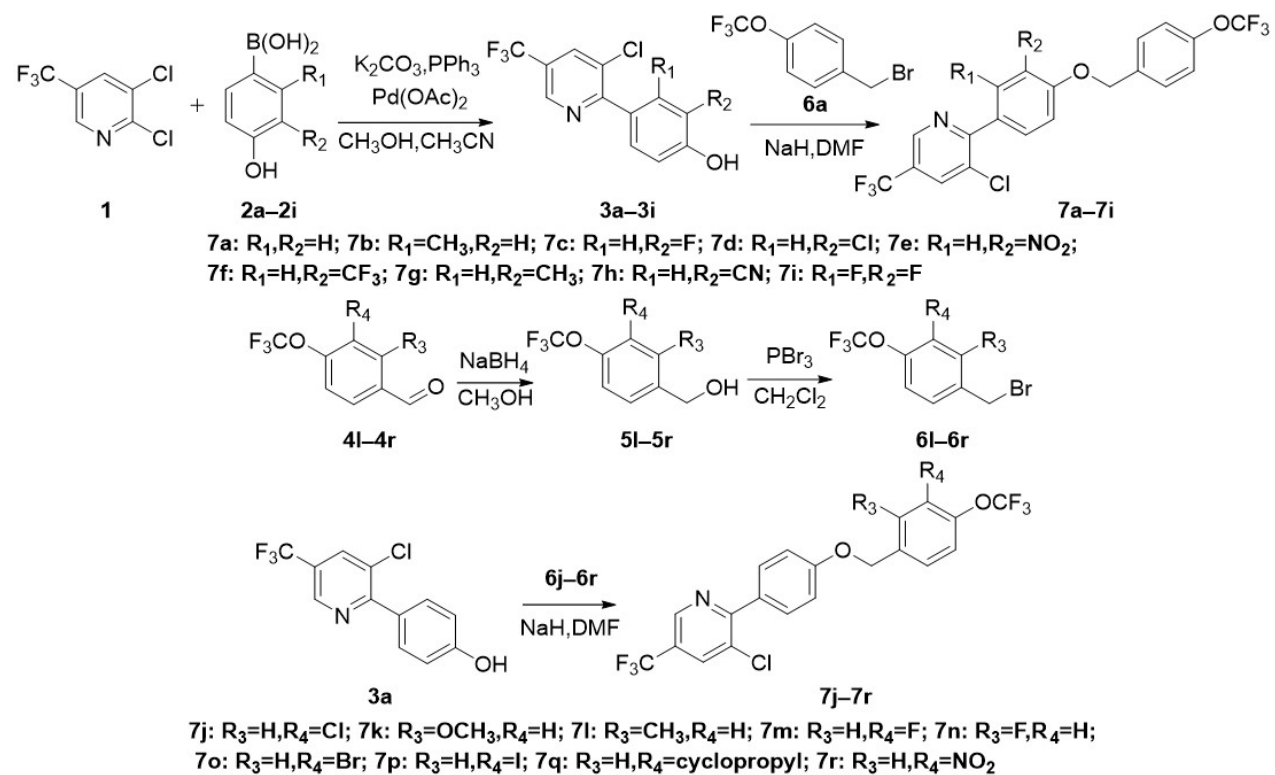
Scheme 1. Synthesis of α -trifluoroanisole derivatives containing substituted phenylpyridine